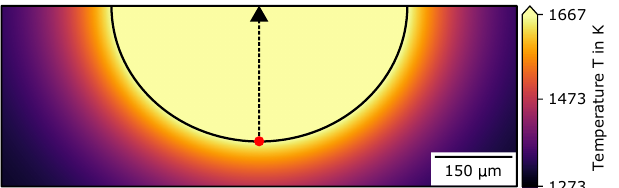
Figure A2. Snapshot of temperature field and melt pool geometry at the turning point perpendicular to the beam movement. The dashed line shows where the solidification pathway was examined. The red dot shows the point where the temperature evolution was tracked over time. The beam velocity and beam power for melting were 0.25ms − 1 and